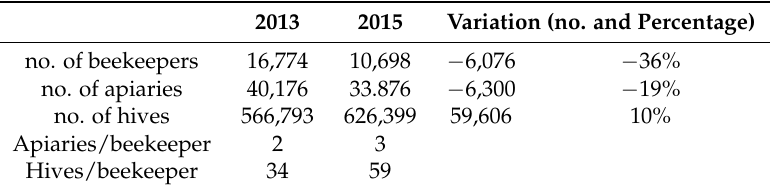
Table 1. Generic Characterization of Beekeeping Activity in